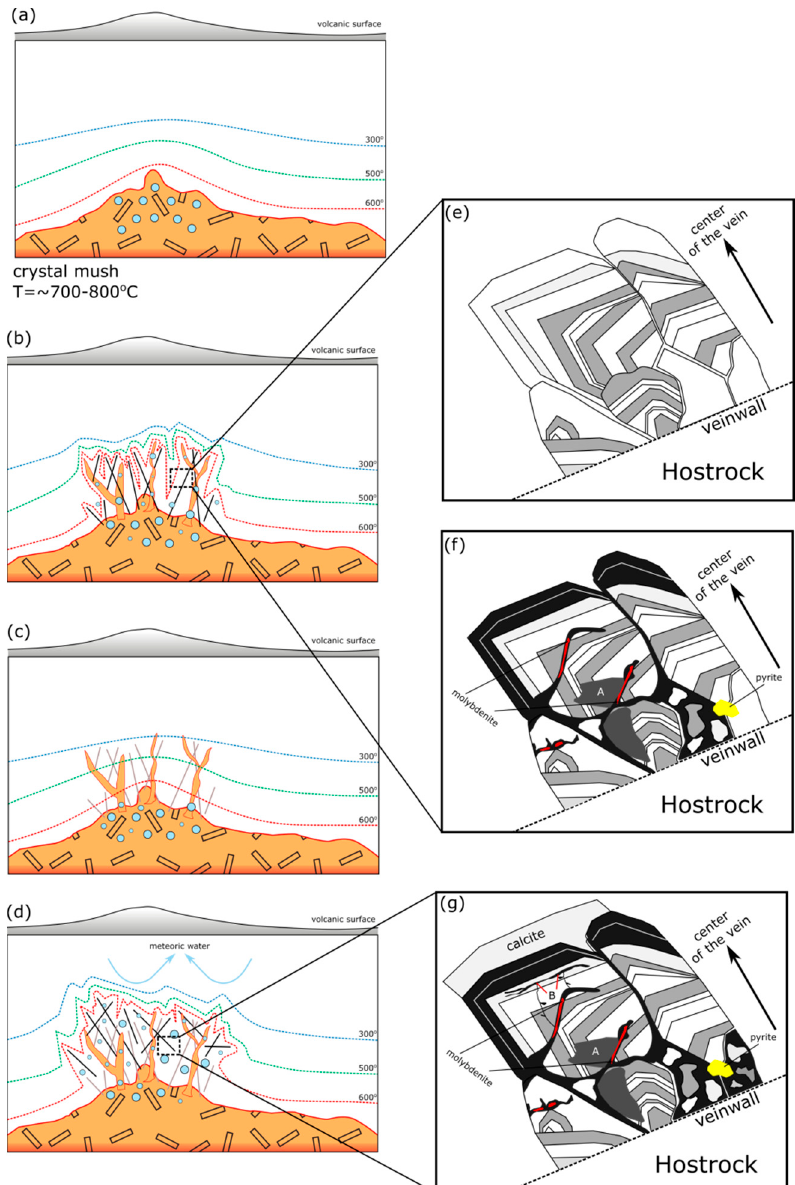
Figure 11. Schematic model of the evolution of magmatic–hydrothermal fluids at the Erdenet deposit and illustration of the crystallization of various quartz veins. Initial magmatic fluid accumulated at the cupola ( a ). Magmatic pulse ( b ) induced the precipitation of the initial euhedral zoning quartz, which has a temperature close to the host rock ( e ). Precipitation of the initial quartz sealed the fracture and increased the fluid pressure. Episodic transience occurred and the fluid was reinjected into the existing fracture, followed by the precipitation of mineralization-bearing quartz ( f ). In the final stages, the magmatic front descends ( c , d ) and the quartz veins precipitate and cut previous generations of veins with cooler temperatures (hydrothermal system) ( g ).